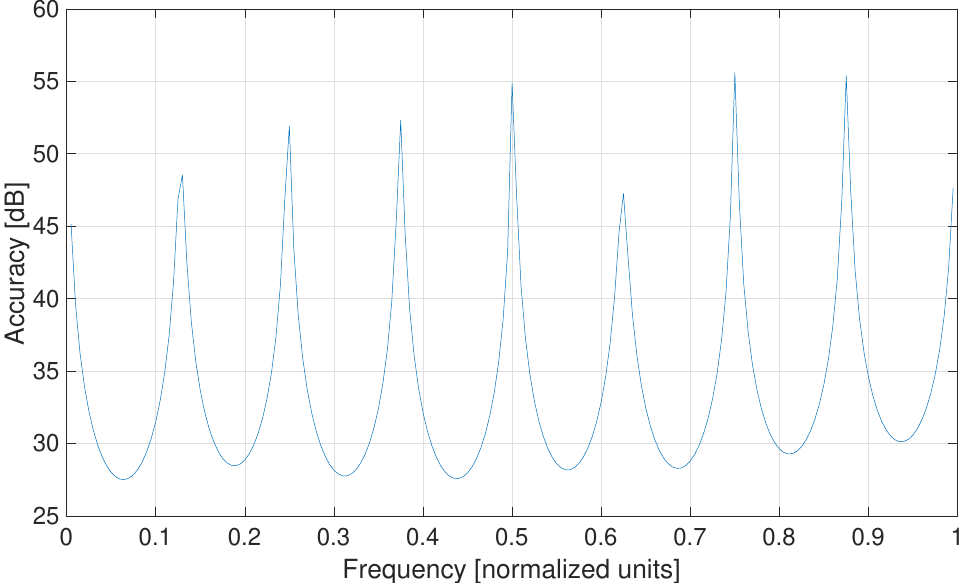
Figure 5. Accuracy is expressed in terms of a KPI defined as the mean value of the ratio, given in dB unit, between the mean square value of the input and the mean square value of the signal, obtained by taking the difference between the applied input and the output of the system. The values are interpolated to have a continuous trace, in order to infer the accuracy of the system at frequencies that have not been directly